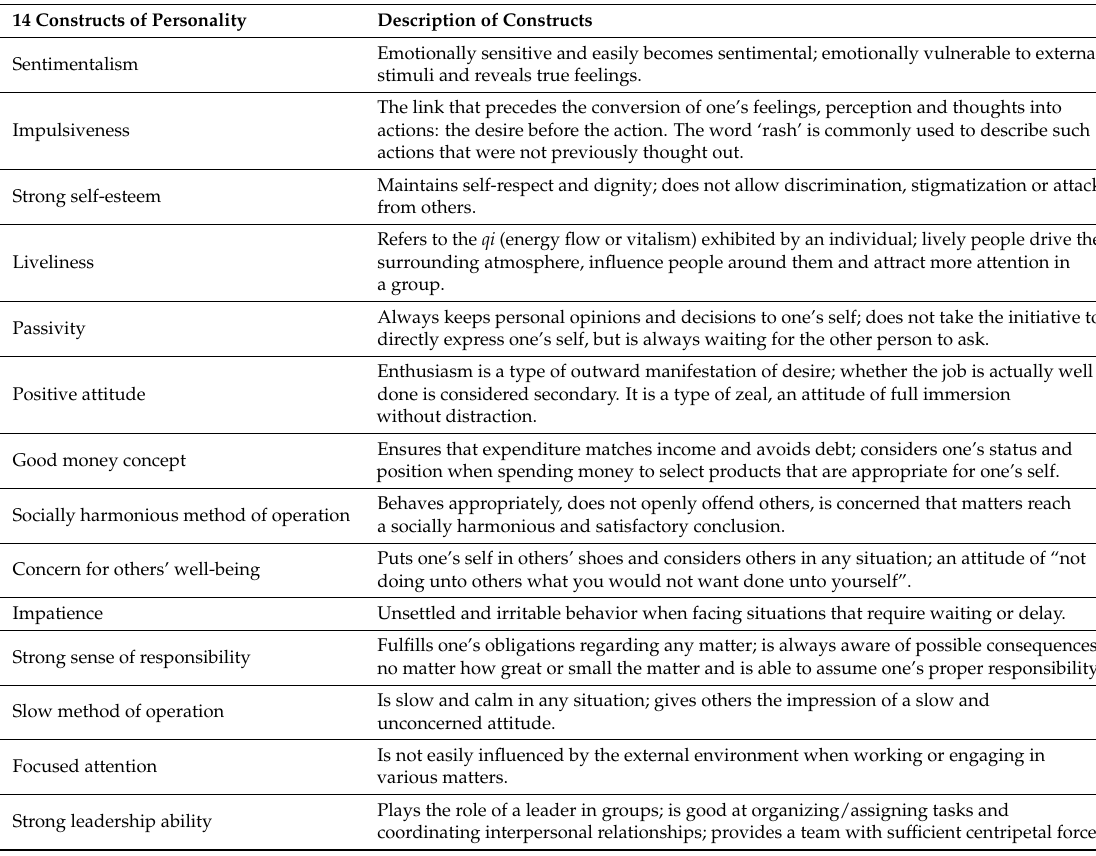
Table 1. Fourteen constructs of